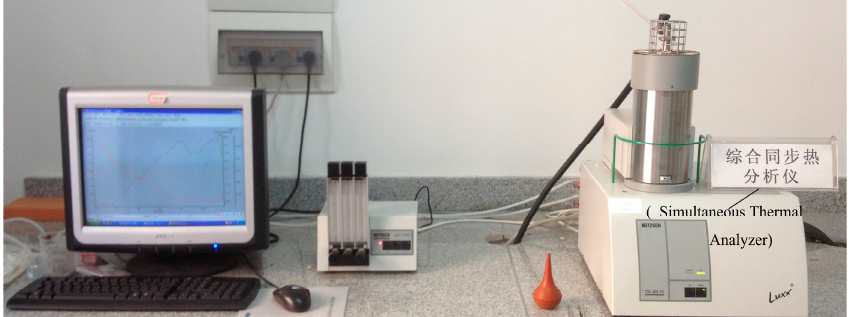
Figure 6. Thermogravimetric analysis process.